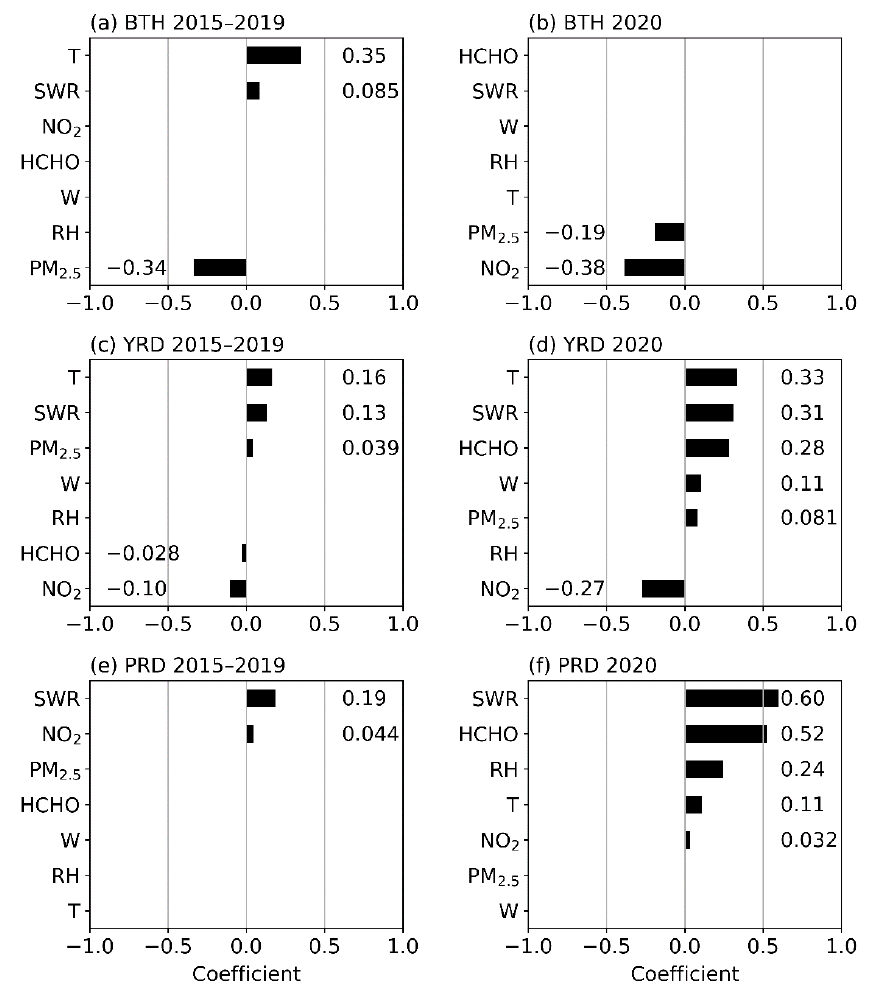
Figure 3. Lasso regression selected driving factors for changes of O 3 during 2015–2019 and 2020 for ( a , b ) BTH, ( c , d ) YRD and ( e , f ) PRD regions. SWR: shortwave radiation flux; RH: relative